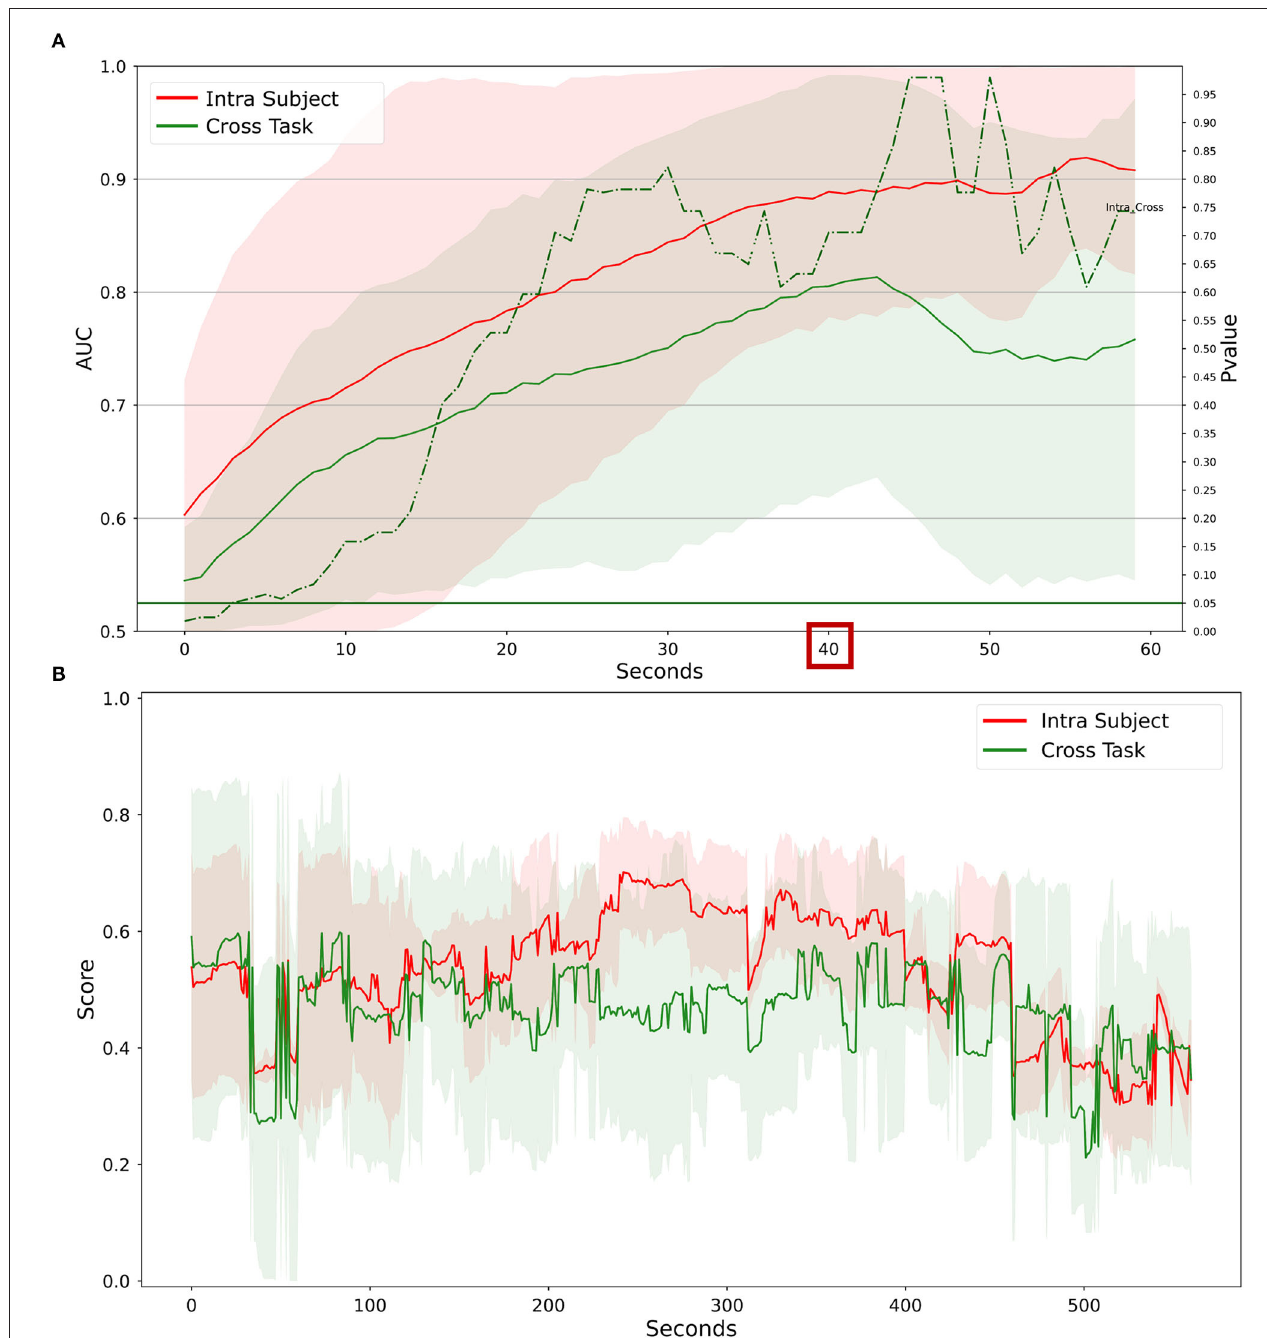
FIGURE 14 | Comparison between intra-subject and cross-task calibration for vigilance discrimination in a realistic setting. (A) AUC values obtained by water electrodes through intra-subject (red) and cross-subject (green) calibration for different time resolutions (1–60s). The solid lines represent the median of the AUC among the participants. The shadows represent the mean absolute deviation of the AUC across participants. The dashed green line represents the results in terms of p -values of the Wilcoxon signed-rank test. The threshold of significance ( p = 0.05) has been highlighted in the same color. (B) The vigilance index obtained from each of the two models at 40s of temporal resolution. The line represents the average over the population, the shadow represents the standard deviation. auditory test, and the time of familiarization is shorter than those required for the MATB (Comstock, 1992).